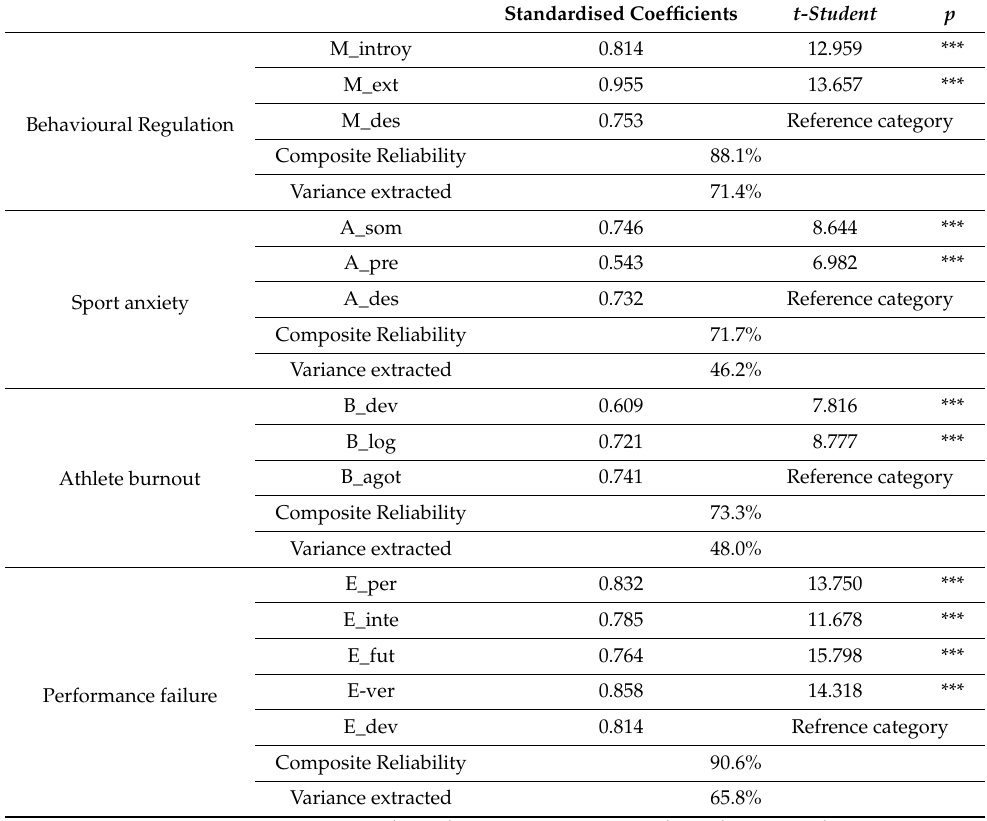
Table 3. Dimensionality and convergent validity of measurement scales.